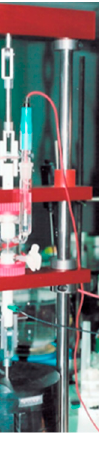
Figure 7. The electrochemical stress corrosion cell and the hanging weight system.